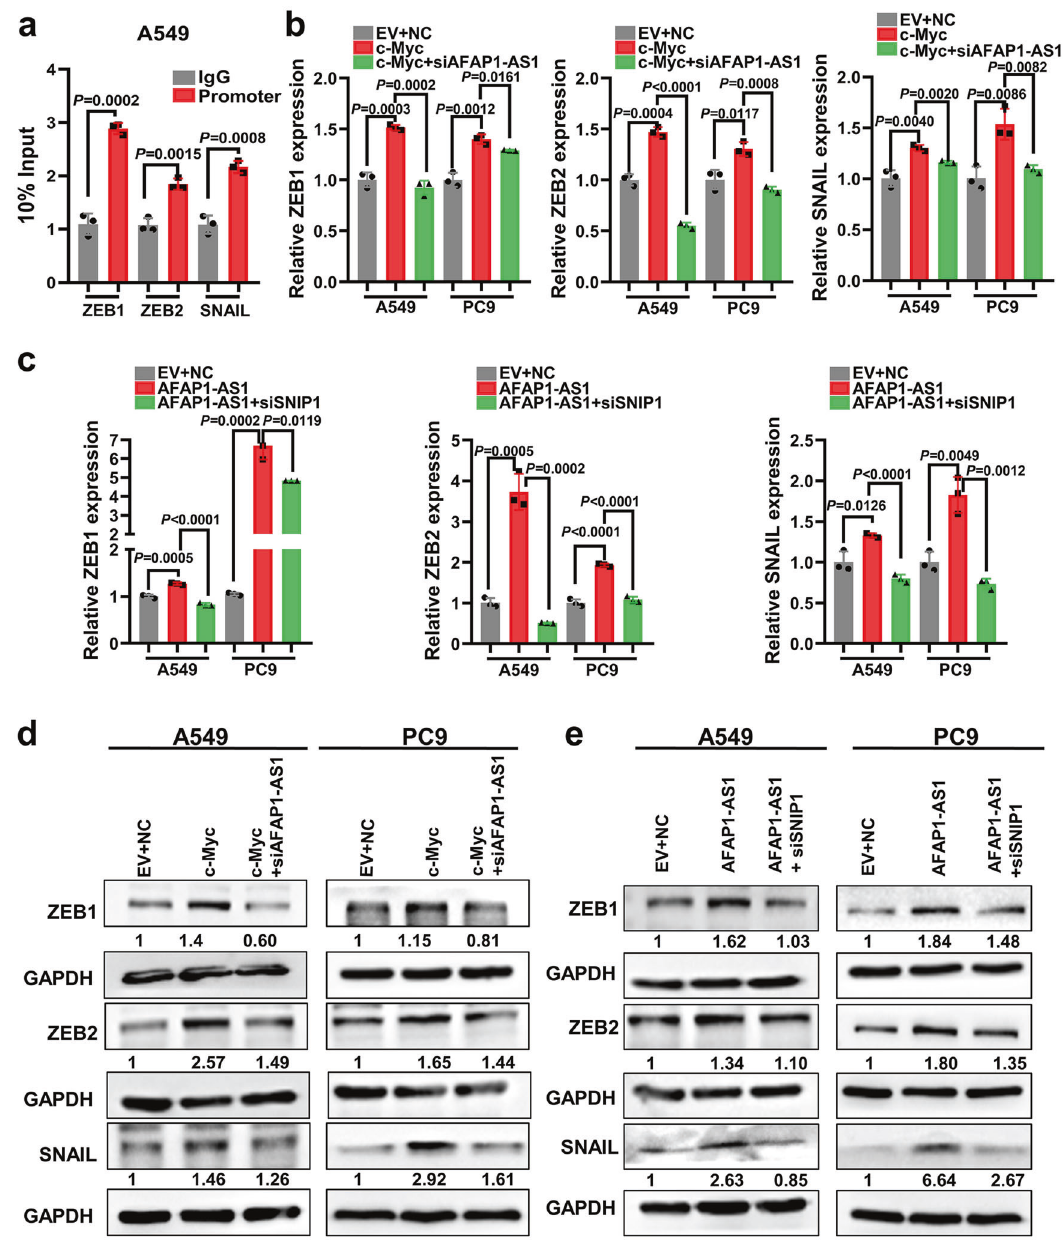
Fig. 8 AFAP1-AS1 upregulates ZEB1, ZEB2, and SNAIL transcription through promoting the binding between SNIP1 to c-Myc. a Chromatin immunoprecipitation experiments showed that c-Myc protein binds to the promoter regions of ZEB1, ZEB2, and SNAIL genes and promotes their transcription in A549 cells. b qRT-PCR results showed c-Myc promoted ZEB1, ZEB2, and SNAIL transcription in A549 and PC9 cell lines, whereas knockdown of AFAP1-AS1 weakened the effect of c-Myc on the transcription of ZEB1, ZEB2, and SNAIL. c AFAP1-AS1 promoted the transcription of ZEB1, ZEB2, and SNAIL in A549 and PC9 cell lines, whereas knockdown of SNIP1 weakened the effect of c-Myc on the transcription levels of ZEB1, ZEB2, and SNAIL. d Overexpression of c-Myc induced ZEB1, ZEB2, and SNAIL expression at the protein level in A549 and PC9 cell lines, whereas knockdown of AFAP1-AS1 weakened the function of c-Myc on ZEB1, ZEB2, and SNAIL proteins by western blotting, which is consistent with their transcription levels. e AFAP1-AS1 enhanced the expression of ZEB1, ZEB2, and SNAIL proteins in A549 and PC9 cell lines, whereas knockdown of SNIP1 weakened the effect of c-Myc on ZEB1, ZEB2, and SNAIL proteins expression. All experiments were repeated at least three times. Data are presented as the means ± SD USA) were used for ISH experiment in lung cancer specimens. Xiangya Hospital, Central South University according to the ethical After paraf fi n sections were dewaxed, hydrated and blocked with and legal standards. The patients were provided with the endogenous peroxidase, the ISH kit (Boster, Wuhan, China) was informed consent before surgery. used to detect AFAP1-AS1 expression in lung cancer tissues. The ISH results were scored according to the staining area and In situ hybridization (ISH) depth. The scoring criteria of staining area were as follows: when Three different nucleotide probes of AFAP1-AS1 labeled with DIG- the number of positive cells was 0, then the score assigned was 0; dUTP at both of the 3 ′ and 5 ′ ends (Invitrogen, Carlsbad, California, Signal Transduction and Targeted Therapy (2021)